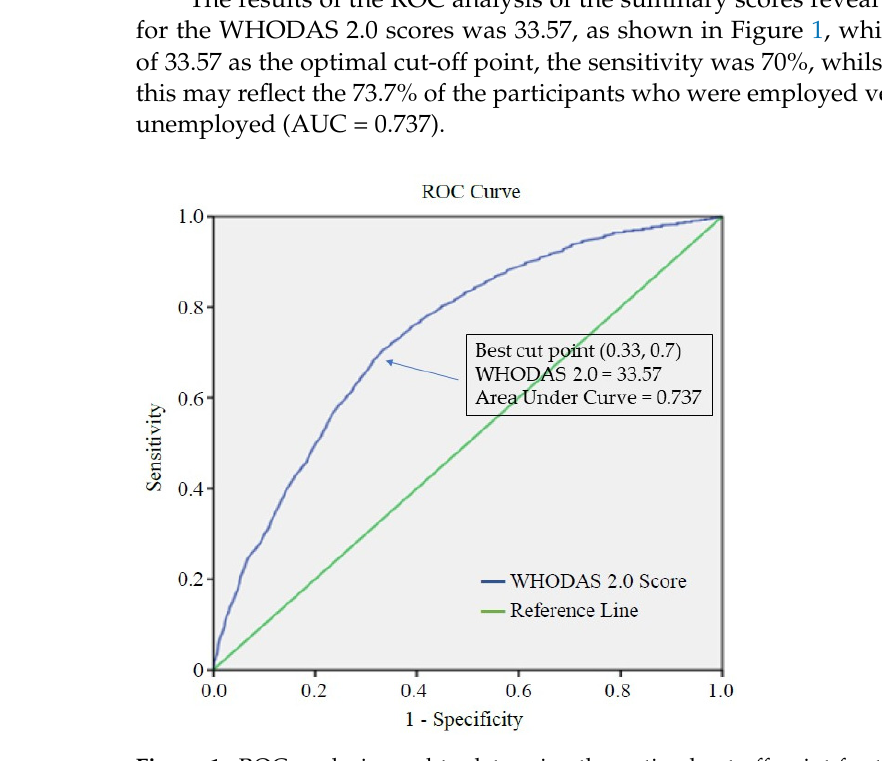
Figure 1. ROC analysis used to determine the optimal cut-off point for the WHODAS 2.0 score. Note: WHODAS 2.0 Score = 33.57; Area under Curve = 0.737; Sensitivity = 0.70; 1-Specificity = 0.33. Sensitivity/(1-Specificity) or LR+ = 2.12.